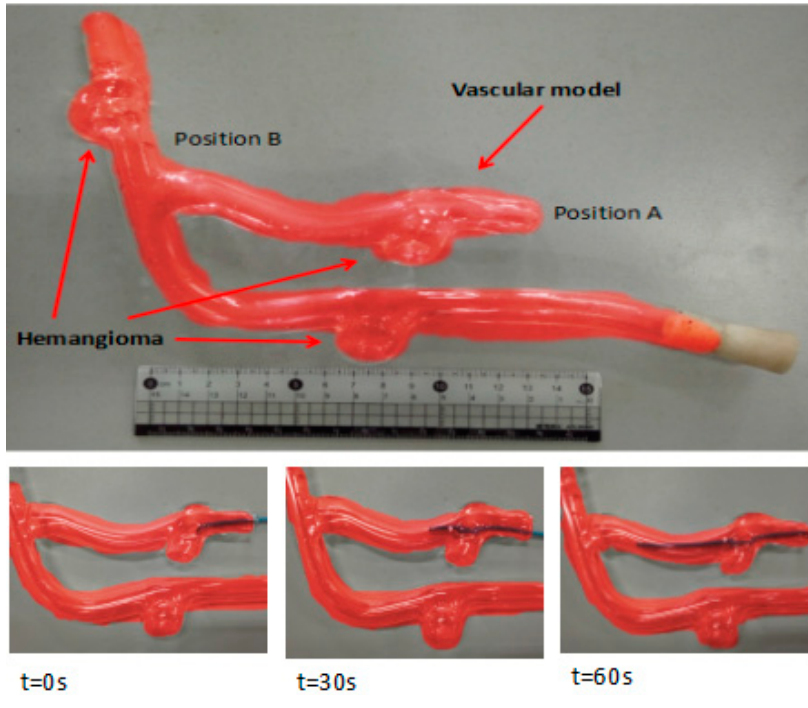
Figure 10. Experimental blood vessel model.